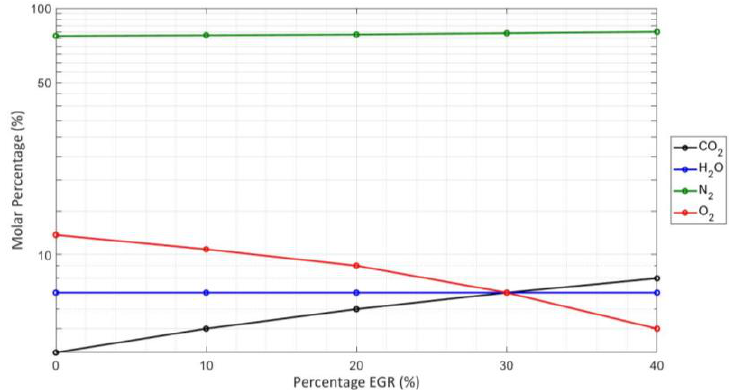
Figure 3. Molar composition of the flue gas stream at various exhaust gas recirculation (EGR) ratios.